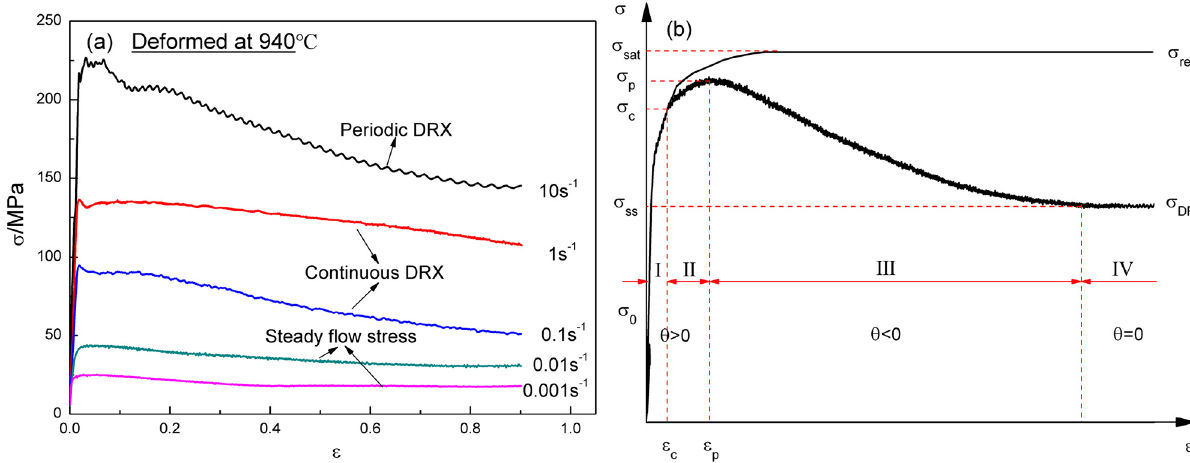
Figure 2: ( a ) True stress – strain curves of Ti – 6.5Al – 2Sn – 4Zr – 4Mo – 1W – 0.2Si alloy under di ff erent deformation conditions and ( b ) schematic diagram for di ff erent deformation stages illustrated on typical fl ow